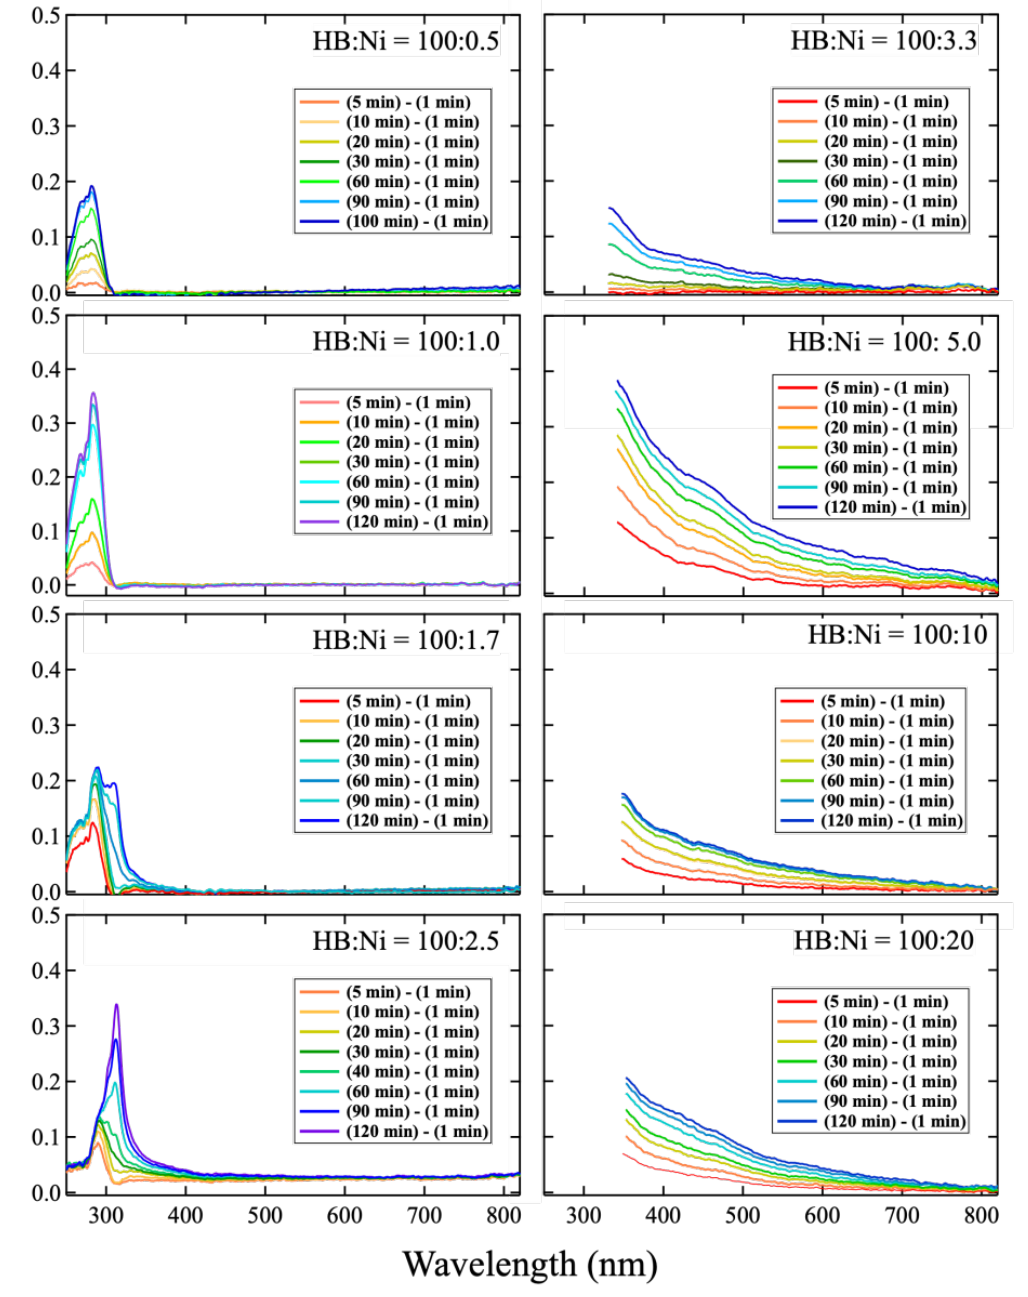
Figure 3. Subtracted spectra from UV-vis measurement; each spectrum shows a difference immediately after mixing (1 min). For the sample of HB:Ni = 100:2.5, the subtracted spectrum of “(40 min)-(1 min)” is also presented because it shows multiple components.